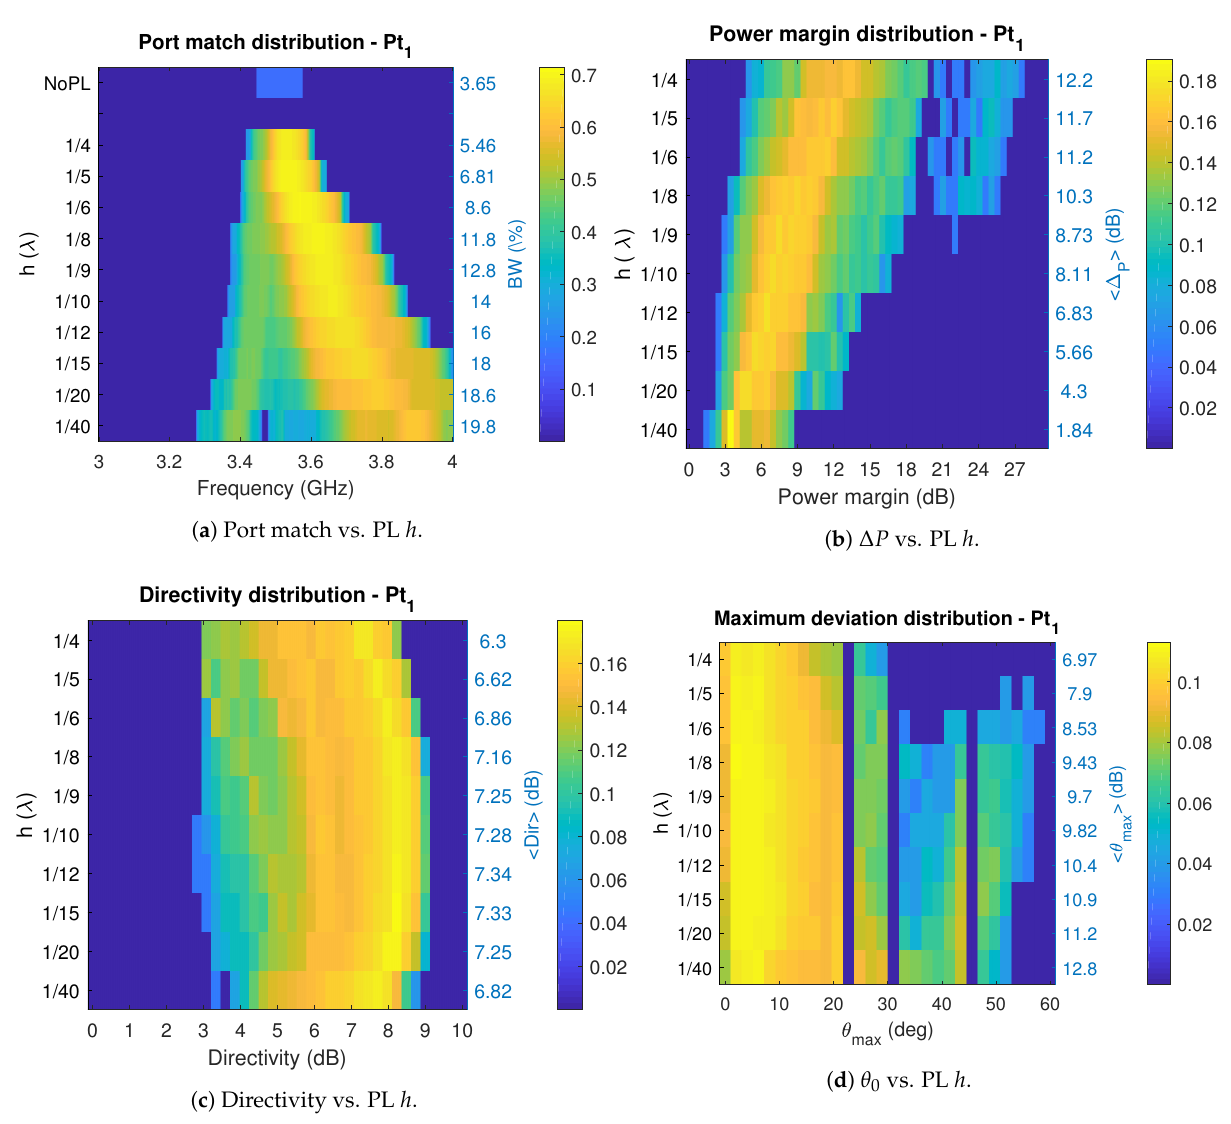
Figure 12. Parasitic-Layer-based Reconfigurable-antenna tradeoffs. Variation of directivity with h is shown in Figure 12c. Directivity is preferred over gain to isolate the effect of the PL on the shape of the radiated field, without including the effects of port matching. This figure shows that directivity can be improved up to a pair of dBs with respect to that of the basic antenna. Most importantly, for a wide range of height variations ( λ /20 − λ /6 ) , on average, the effect of the PL does not lead to a degradation of directivity when compared to that of the base